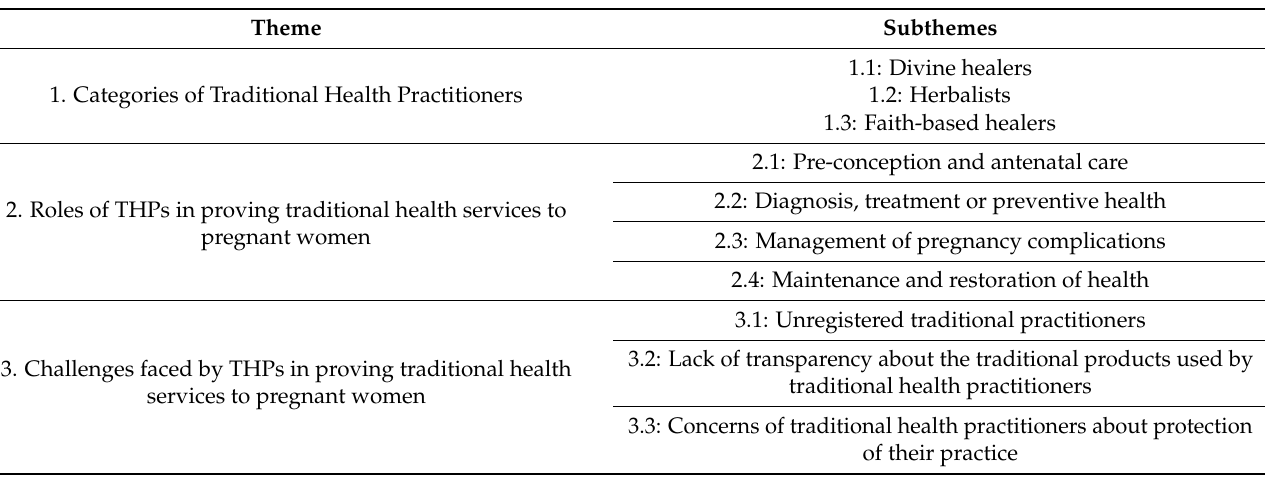
Table 2. Themes and sub-themes that emerged from the